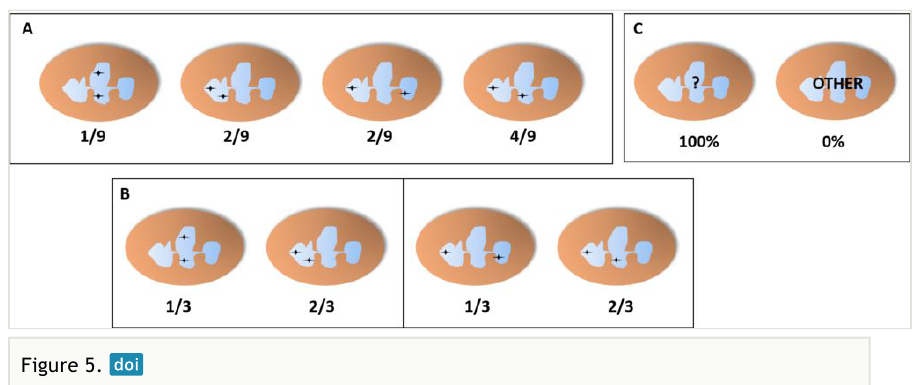
Probability of fi nding each distribution of the alleles in a neutrophil with three lobes through the microscope, assuming an independent pattern (A, assuming an equal chance for all lobes), pattern of interdependent location independent of lobe (B) or pattern of interdependent location in a fi xed lobe (C). In B, we fi nd two distributions with the shown proportions (either the two on the left or the two on the right) and the other two distributions have a probability of 0%. In C, one of the distributions would be present in 100% of the cells while the others would not appear.